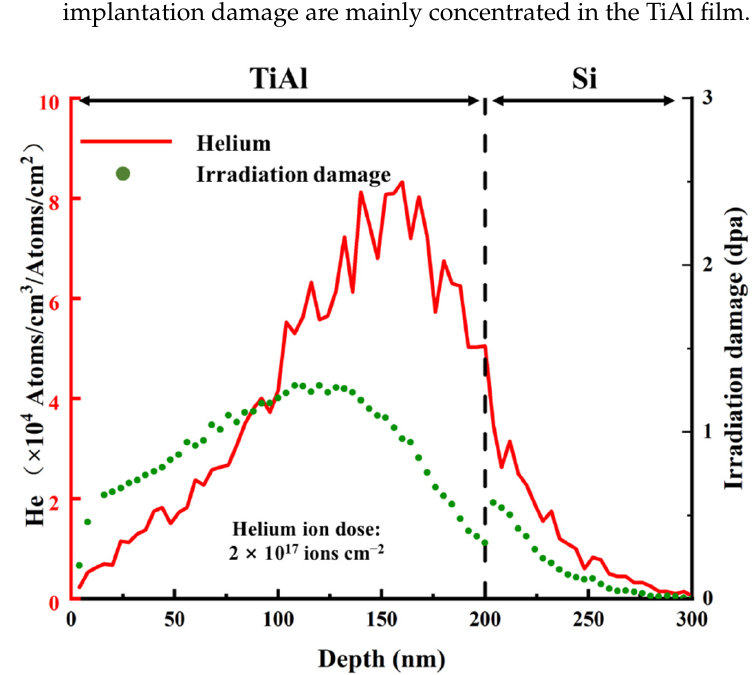
Figure 2. The depth profile of helium atoms and DPA in the TiAl film implanted by 20 keV helium ion simulated using SRIM .